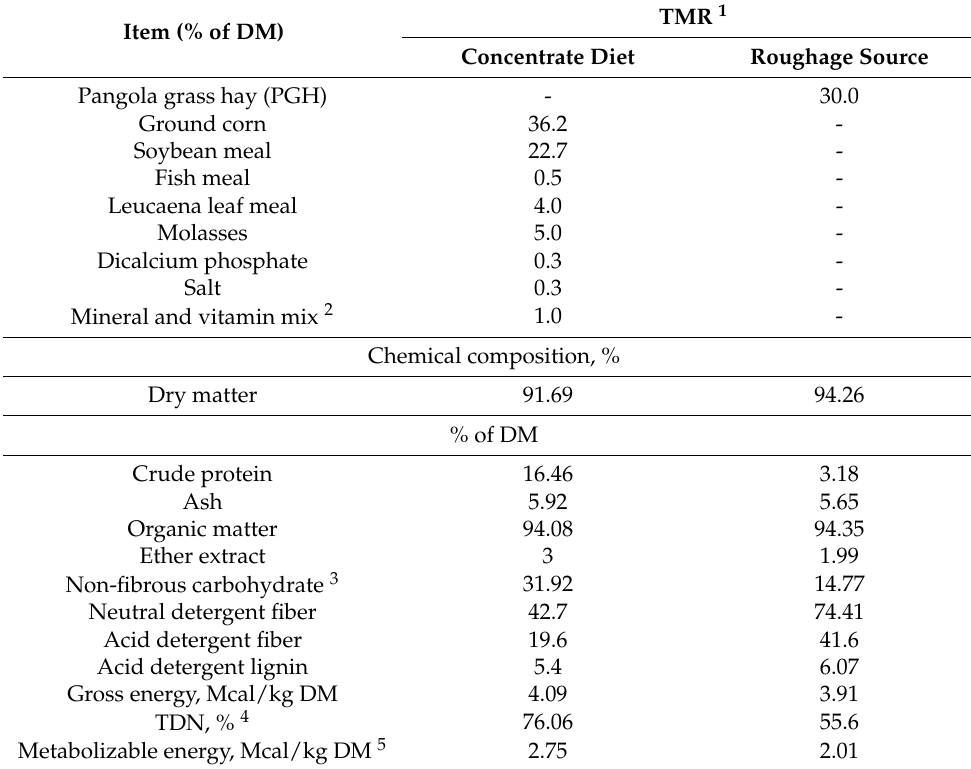
Table 1. Dietary ingredients and chemical composition of total mixed ration (TMR) and Pangola grass hay (PGH) fed to the goats during the trial. TMR 1 Item (% of DM) Concentrate Diet Roughage Source Pangola grass hay (PGH) - 30.0 Ground